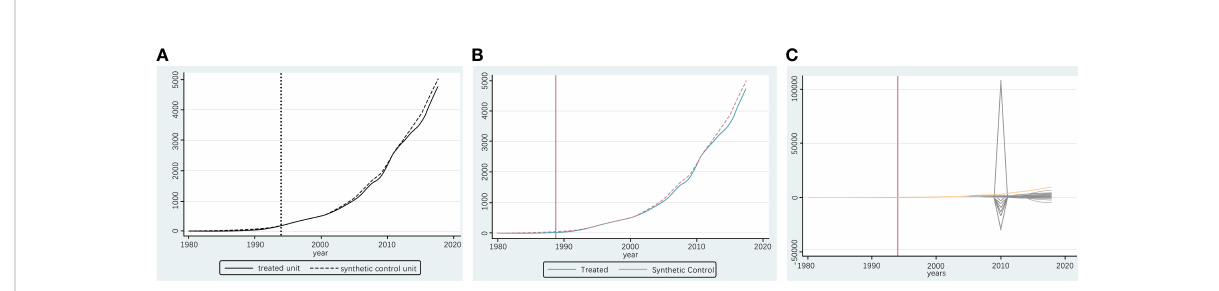
FIGURE 5 Ranking test results. (A) Difference in GDP between Zhuhai City and Synthetic Zhuhai City. (B) Difference in GDP between Xiamen and synthetic Xiamen. (C) Ranking test